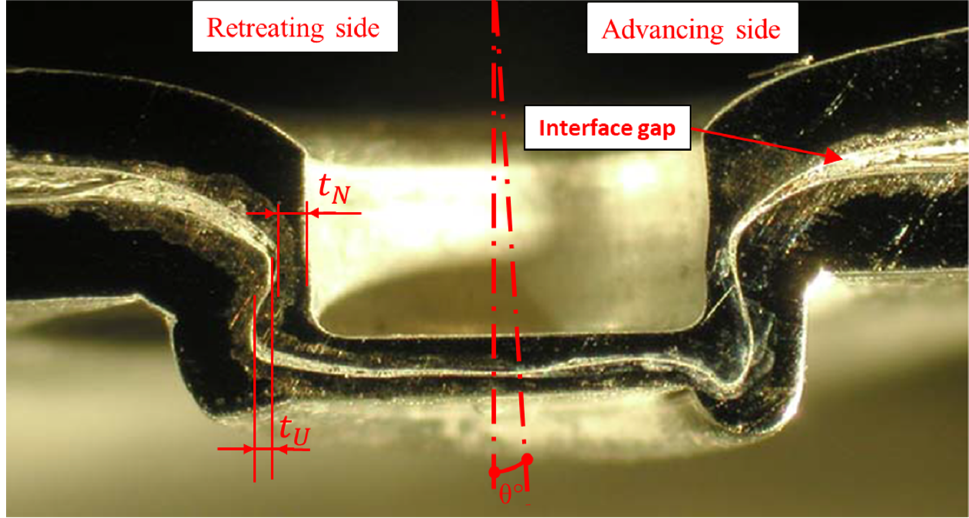
Figure 21. Cross section of a steel clinched joint has a diameter of 6.0 mm on the die side [28].